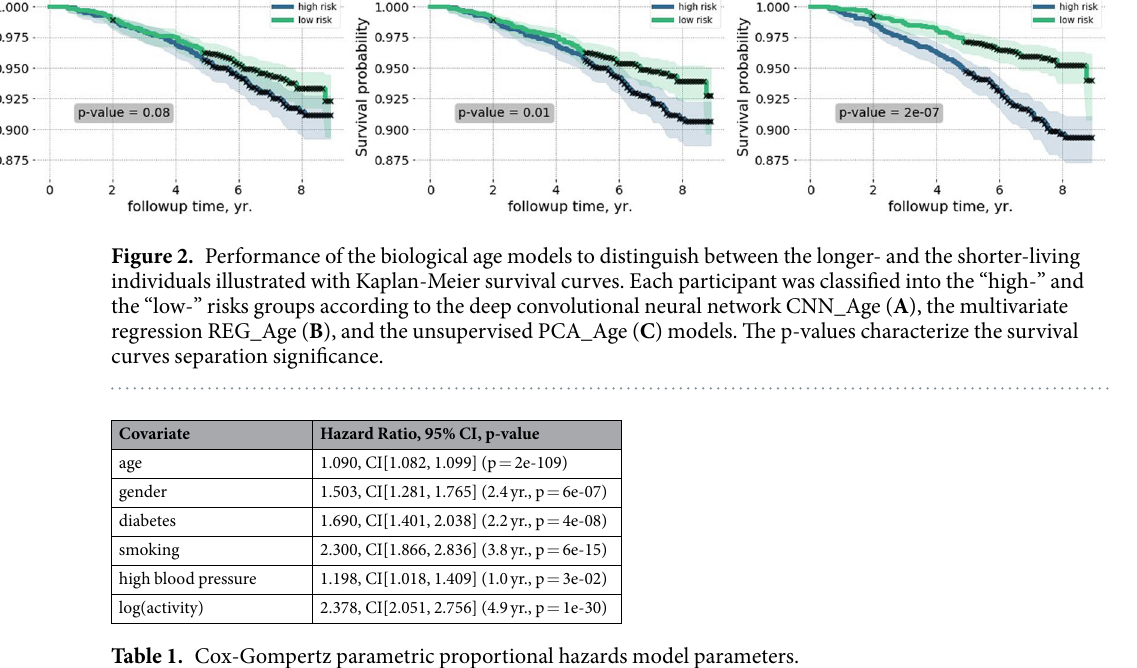
Table 1. Cox-Gompertz parametric proportional hazards model